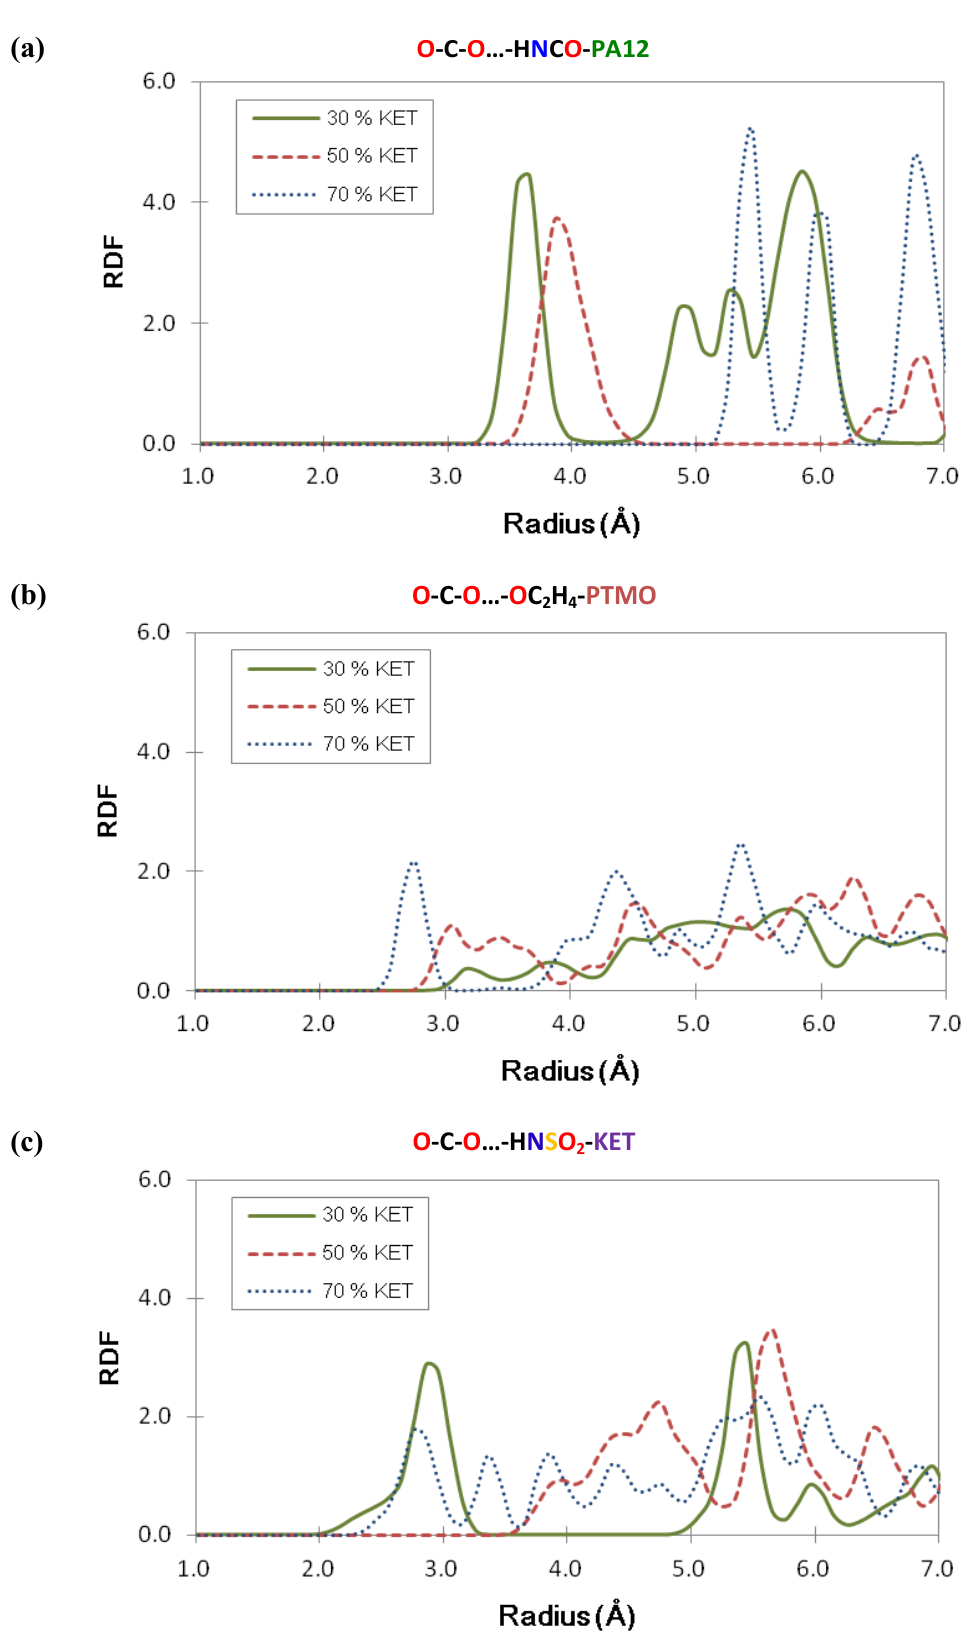
Figure 8. Radial distribution functions (RDF) between the oxygen of CO PA-12 amidic group; ( b ) the O of the PTMO group; ( c ) the HN of the sulphonamidic group of KET in PEBAX/KET